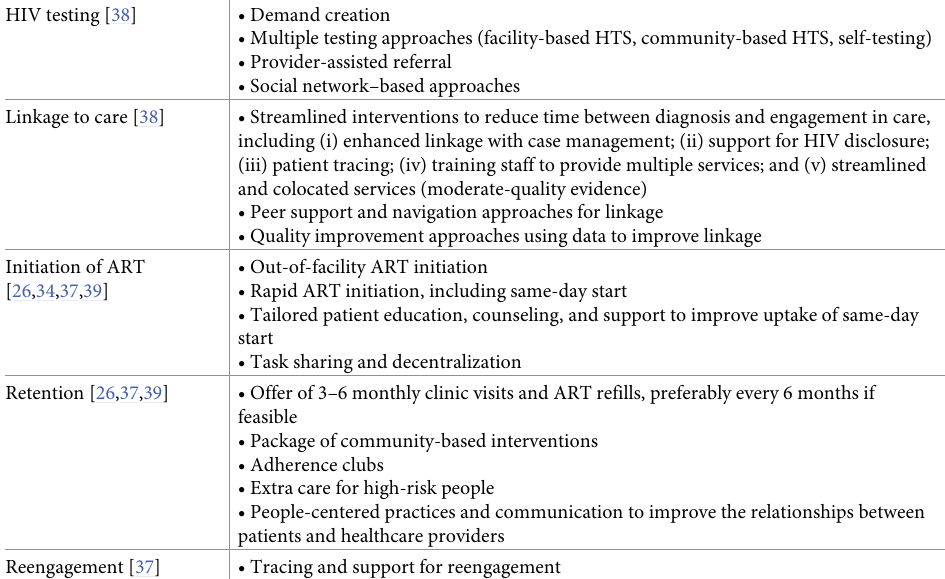
Table 2. WHO evidence-based recommendations and good practice statements to strengthen the